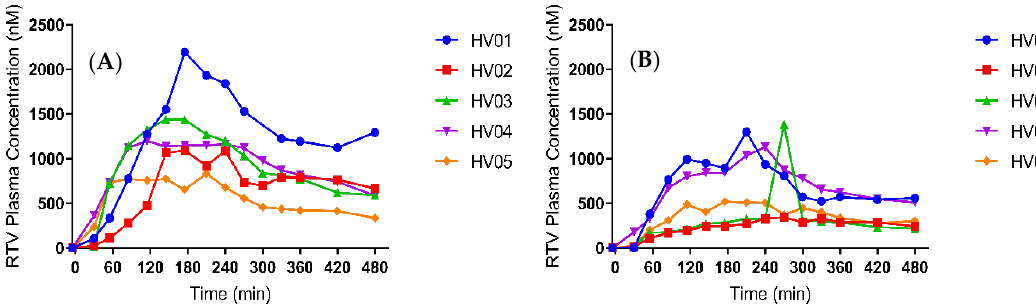
Figure 3. Plasma concentration-time profiles for ritonavir (RTV) in five healthy volunteers (HV) after oral intake of a Norvir tablet in ( A ) control condition and ( B ) PPI condition.